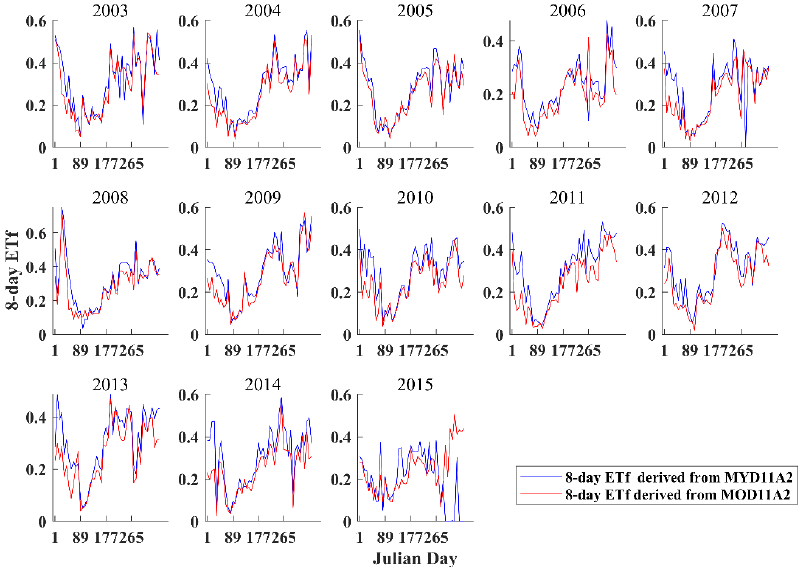
Figure A8. Eight-day ET f derived from the MOD11A1 and MYD11A1 in the whole YRB during the years 2003–2015.